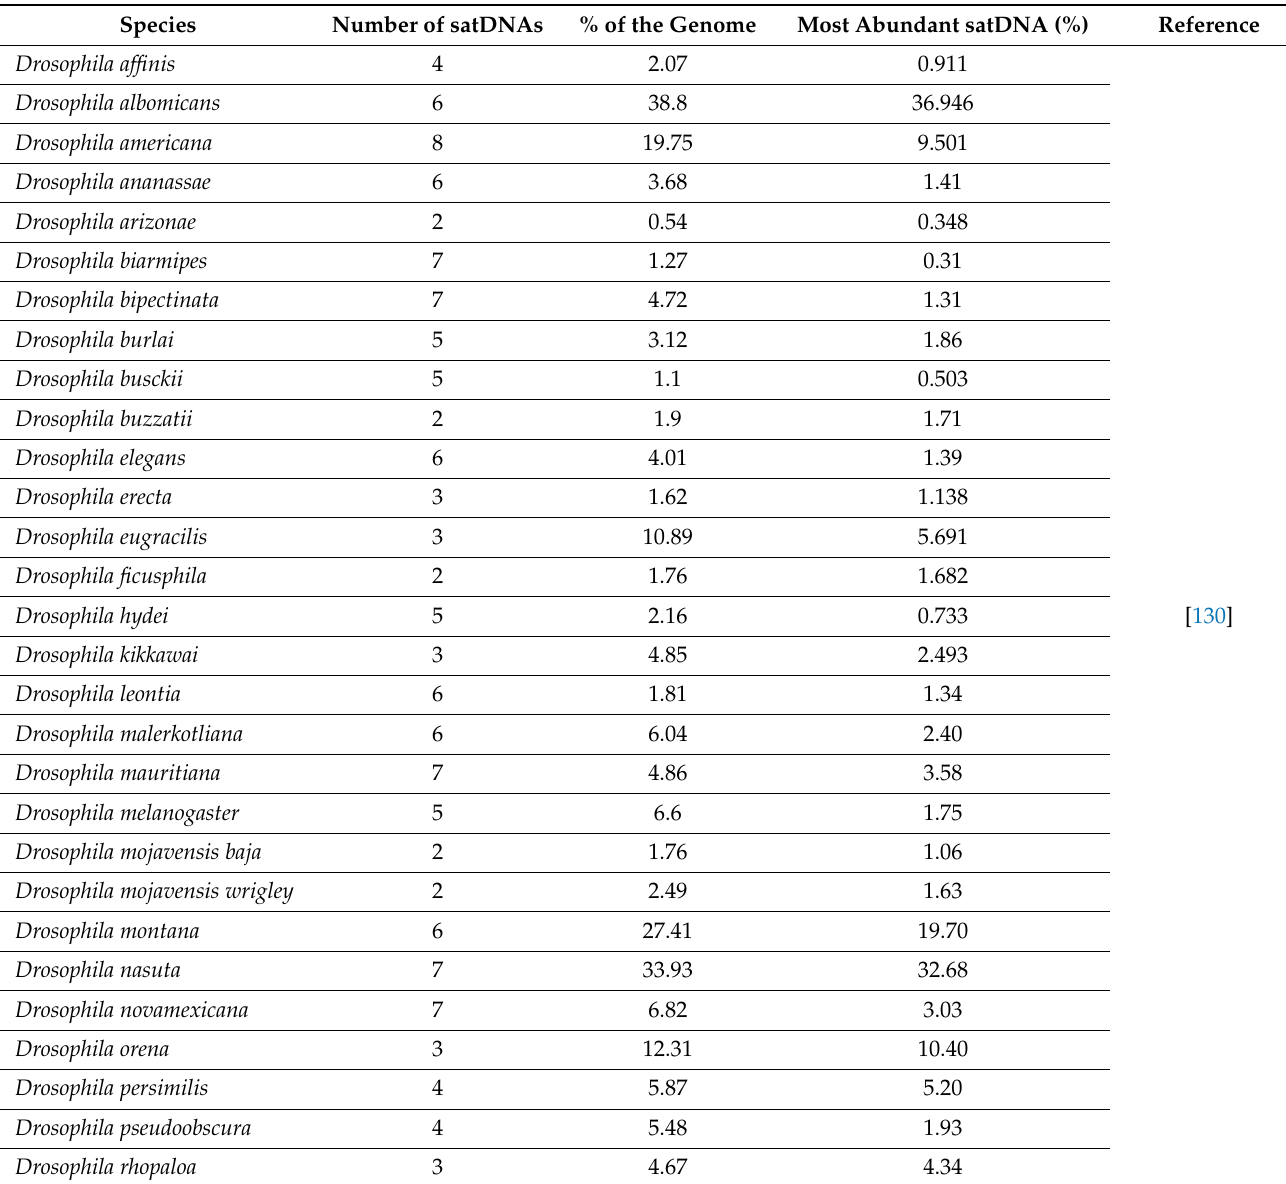
Table 2. Genome contributions of satDNAs detected in the species of the Drosophila